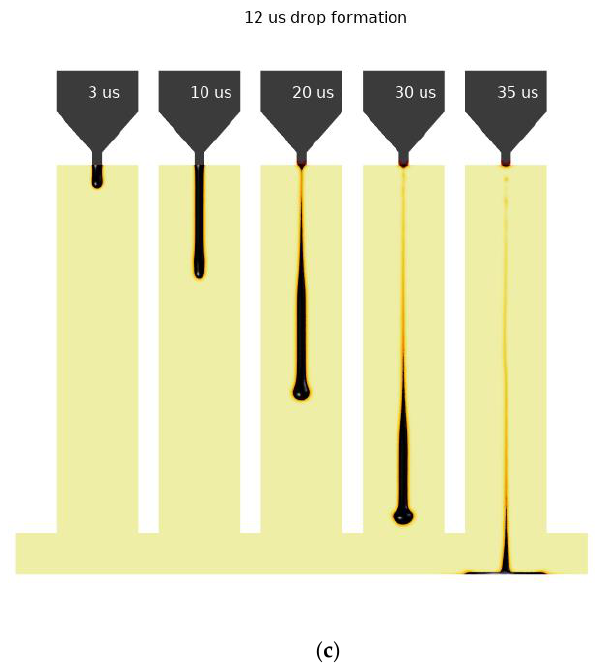
Figure 5. Representation of the movement of ejected droplet with different ejection parameters. Waveform dwelling time: 1 µs ( a ); 3 µs ( b ); 12 µs ( c ). Inlet velocity V in = 0.5 m